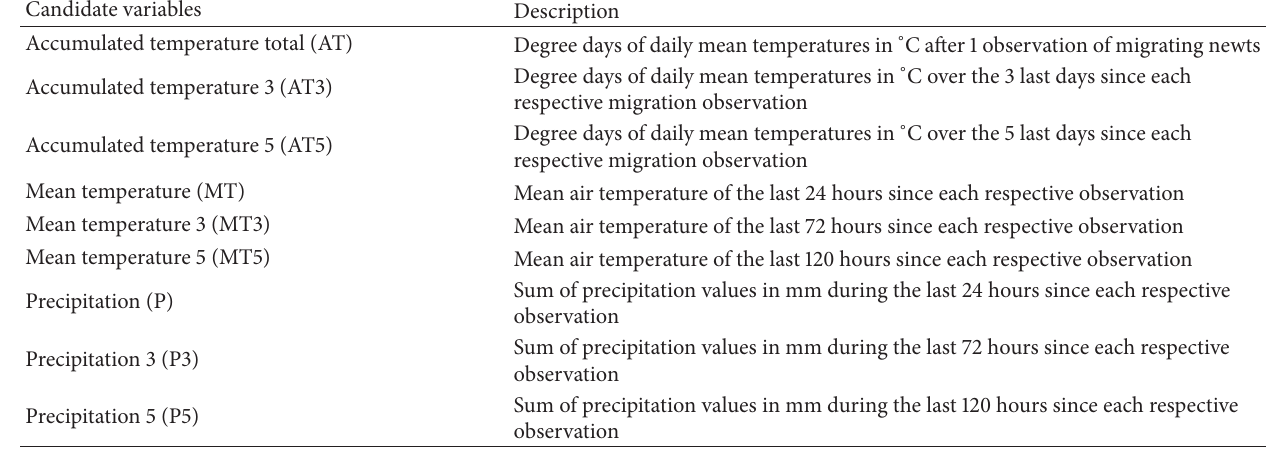
Table 2: Variables considered in the fixed effect structure of the various candidate models for describing newt migration phenology pattern as a function of temperature and precipitation.